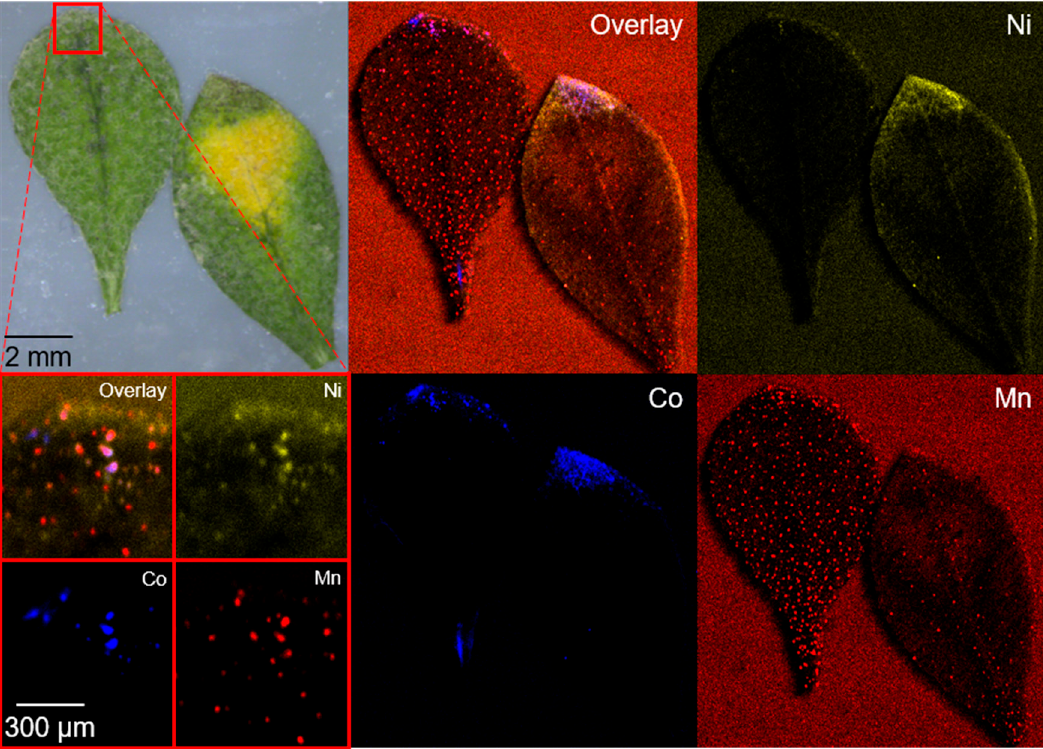
Figure 3. Microscopic and µXRF images of two A. murale leaves, as well as a small section (red square) from the leaf tip after 100 days of NCM111 soil contamination. Co localization is indicated in blue, Ni in yellow, and Mn in red. A dot-shaped distribution was observed for all metals (see small section) and a localization in the tip of the leaves can be seen for Ni and Co. Table 3. Quantified concentrations of Ni, Co, Mn, and Li in mg L − 1 by means of ICP-OES